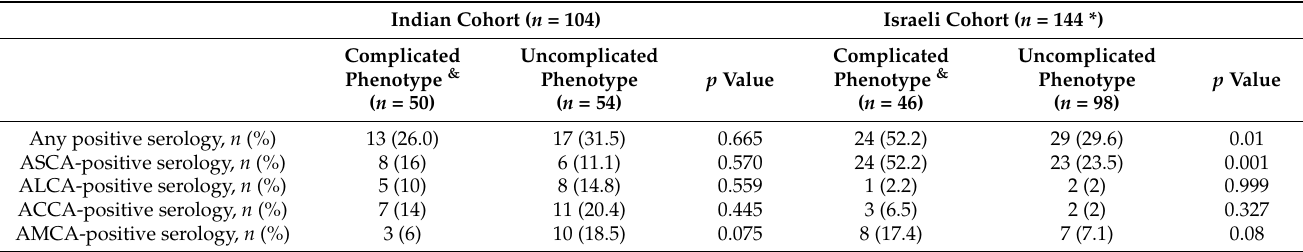
Table 2. Comparison of positive antiglycan serologic responses between patients with newly diag- nosed complicated and uncomplicated CD phenotypes in Indian and Israeli